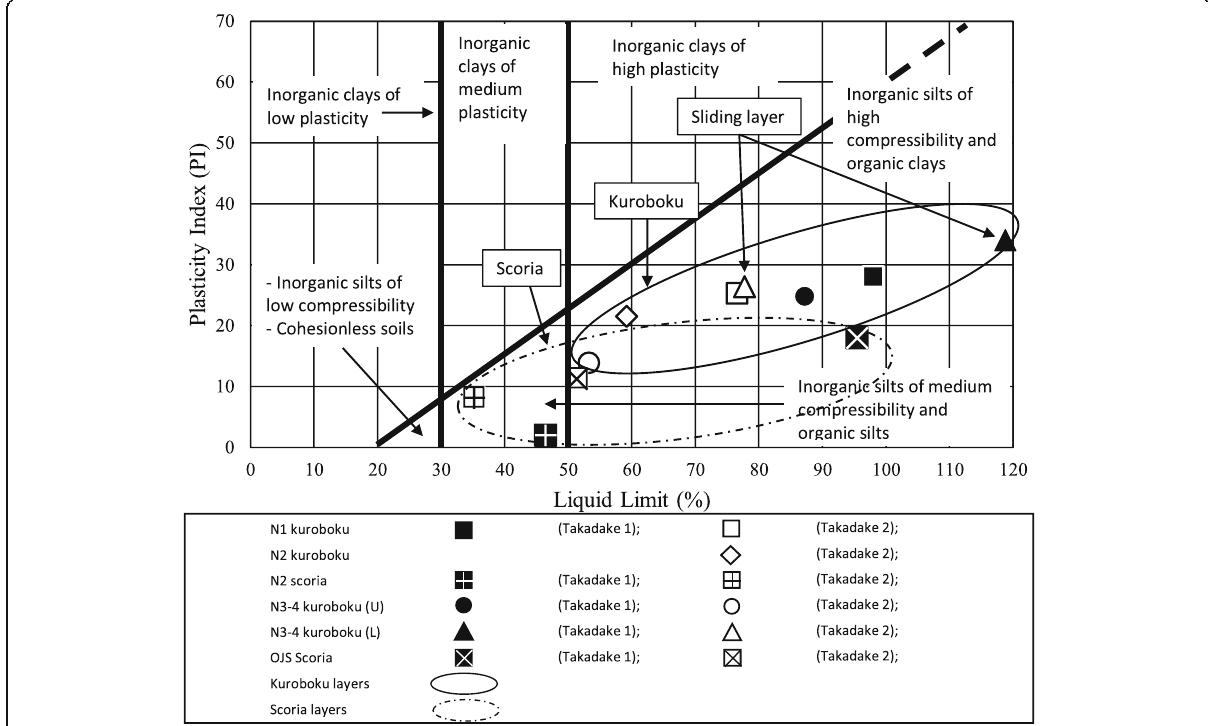
Fig. 6 Plasticity chart shows the dissimilarity between kuroboku and scoria